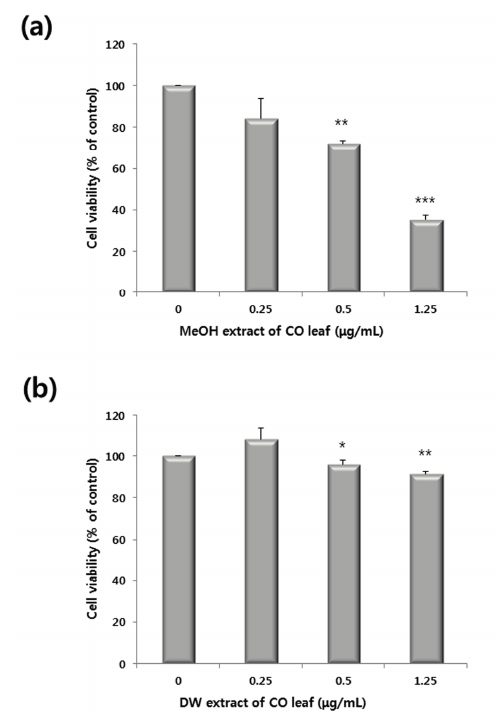
Figure 1. Antiproliferative activity of ( a ) methanol extracts and ( b ) water extracts of Chamaecyparis obtusa (CO) leaves (0–1.25 μ g/mL) against HCT116 human colon